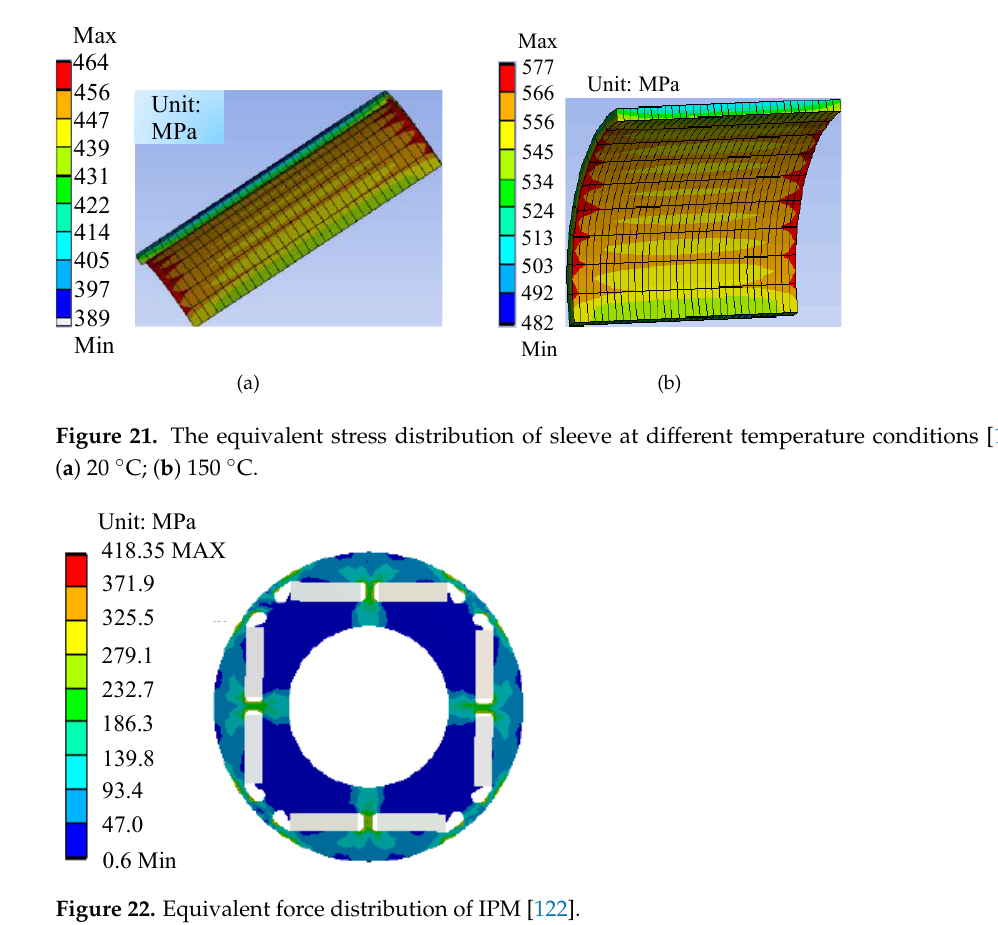
Figure 22. Equivalent force distribution of IPM